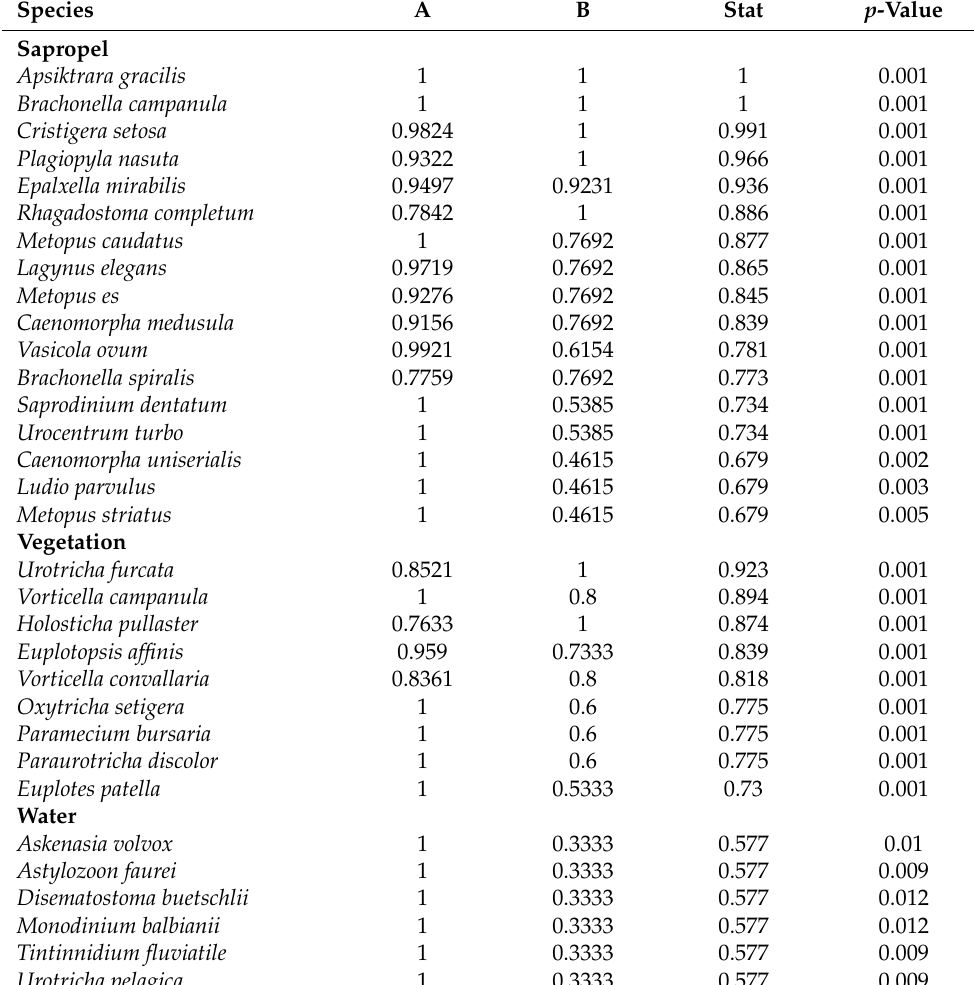
Table 3. List of ciliate species—indicators of habitats: sapropel, water, and plant layer. The column “stat” gives the indicator value of the species in fractions of one. This indicator value is equal to the square root of the product of parameters A and B. “A” is an estimate of the probability that if a given species is found, the habitat is of that type. “B” is the probability of finding a species in a habitat of that